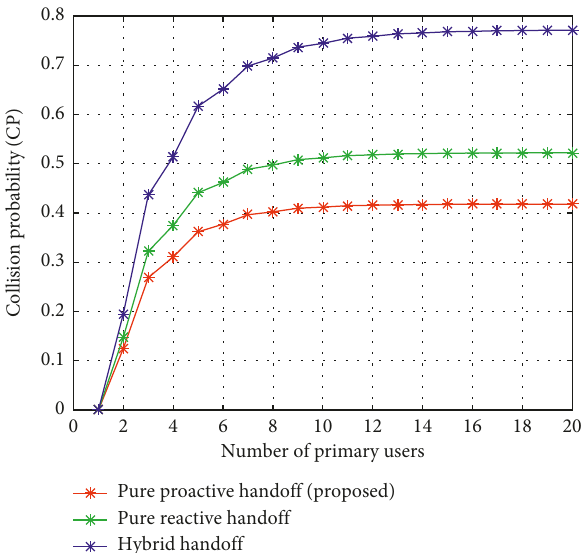
Figure 9: Performance of different spectrum handoff techniques according to the density of PU traffic.